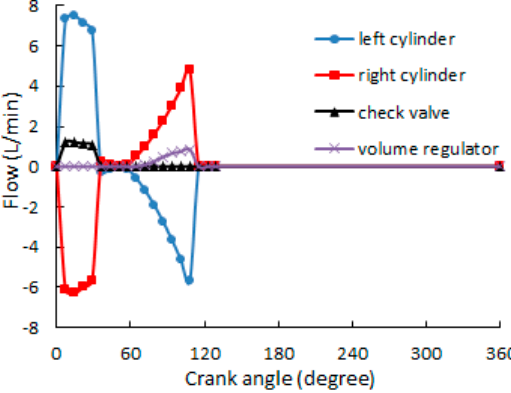
/ min. Appl. Sci. 2019 , 9 , x FOR PEER REVIEW